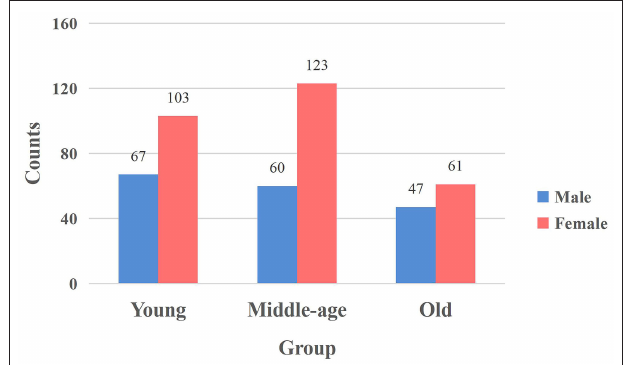
FIGURE 1 | The distribution of males and females in each group. The vertical axis signifies the number of participants, and the horizontal axis represents the age group. The blue bar and red bar represent male and female